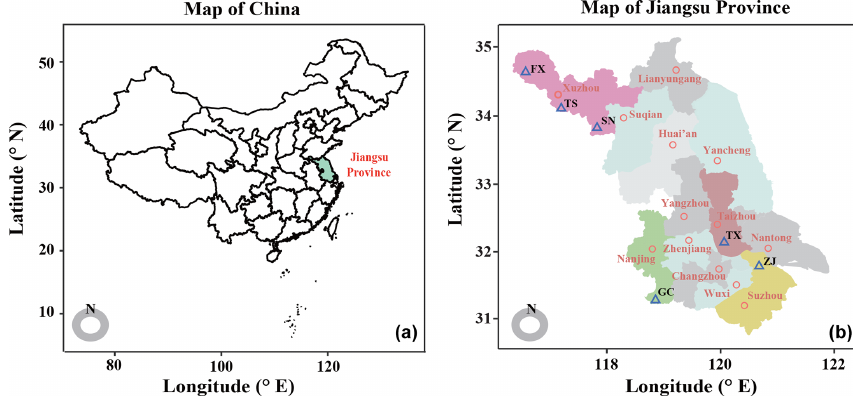
Figure 1. Distribution of studied field sites. Map showing the sites of six pair-located orchards sampled in this